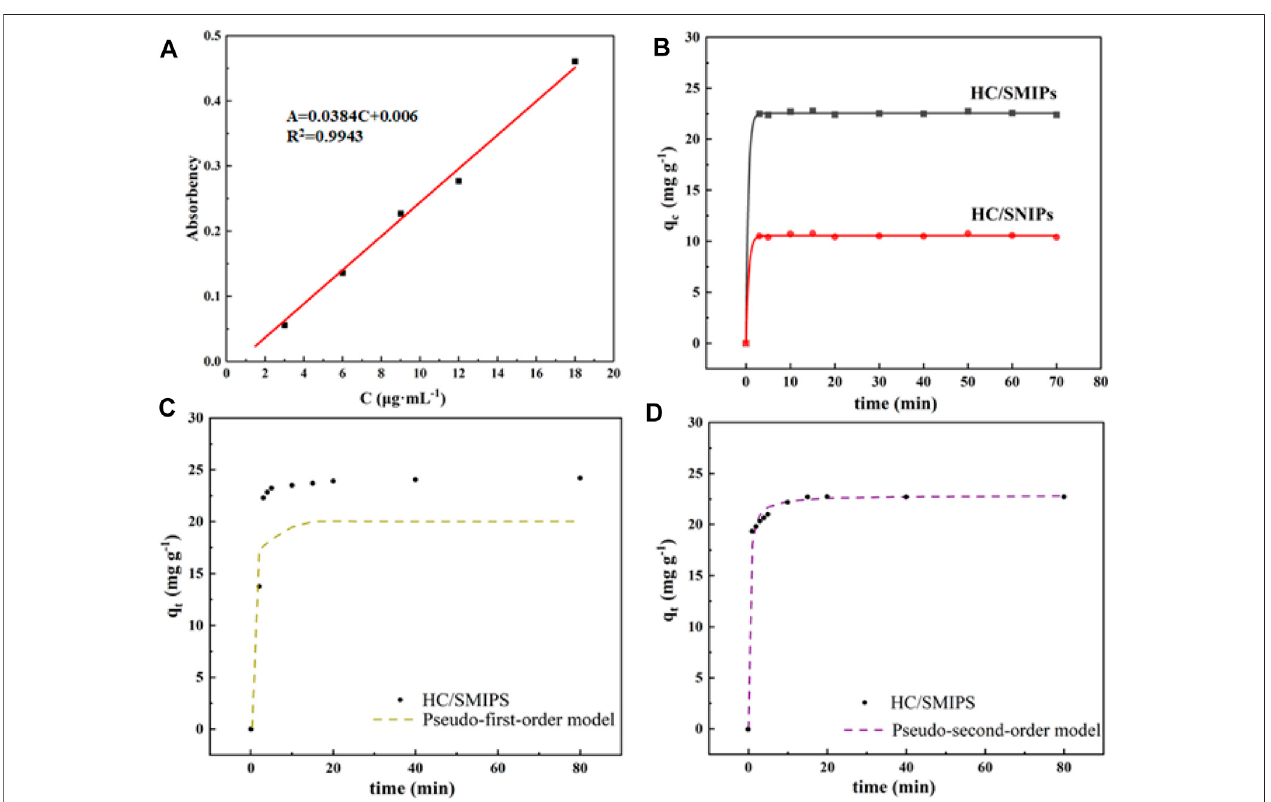
FIGURE 4 | (A) Standard curves of HC adsorption (B) Adsorption kinetics curve of HC/SMIPs and HC/SNIPs; The Fitting adsorption curves of HC/SMIPs with pseudo- fi rst-order kinetic model (C) and pseudo-second-order kinetic model (D) .